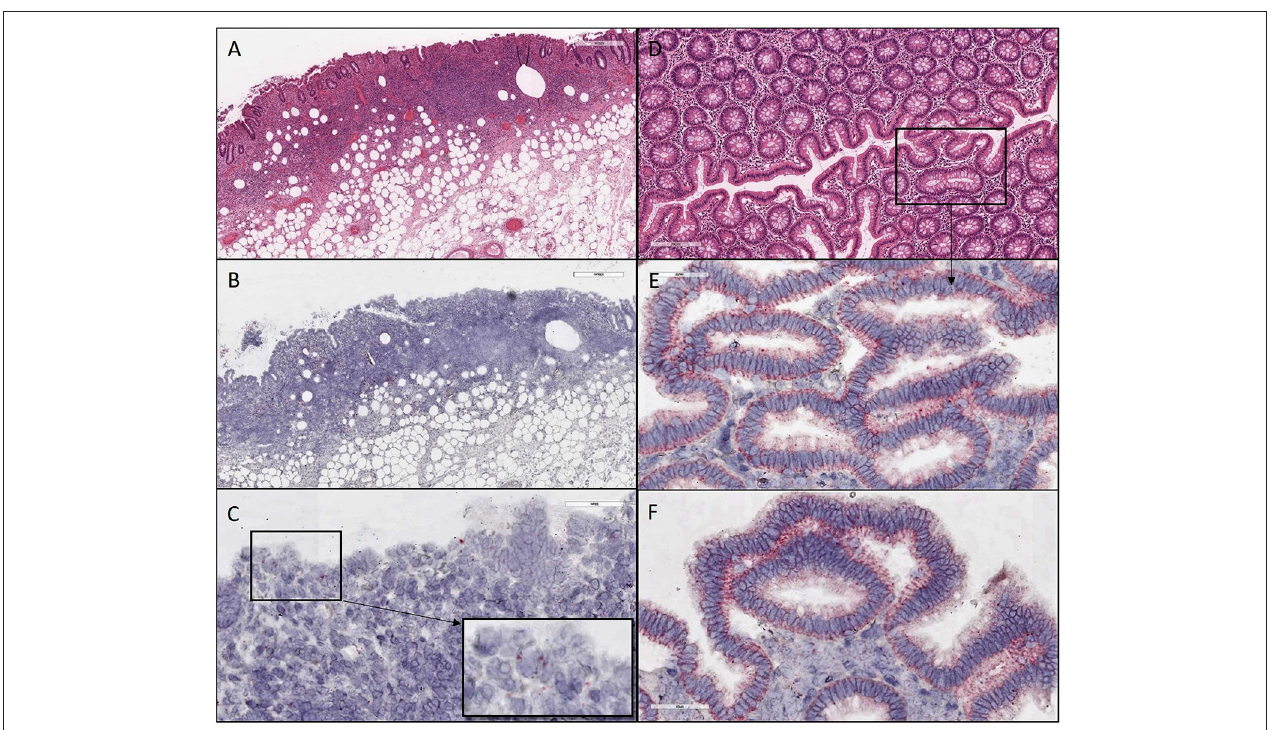
FIGURE 3 | H&E and ISH images of patient #2 in focal mucosal ulcer with granulation tissue formation along with adjacent uninvolved mucosa. (A) H&E images of ulcerated colon tissue at 4X magnification (B,C) Images after in situ hybridization using V-nCOV2019—orf1ab–sense probe (red chromogen) at lower 4X and higher magnification 40x, respectively. (D) H&E images at 10X magnification of adjacent uninvolved mucosa (E,F) in situ hybridization using V-nCOV2019—orf1ab- sense probe detected as red signal in adjacent intact epithelium of uninvolved mucosa at higher magnification images at 40x. Images show pronounced viral load in the surface epithelial lining and the crypts (Basal cytoplasmic